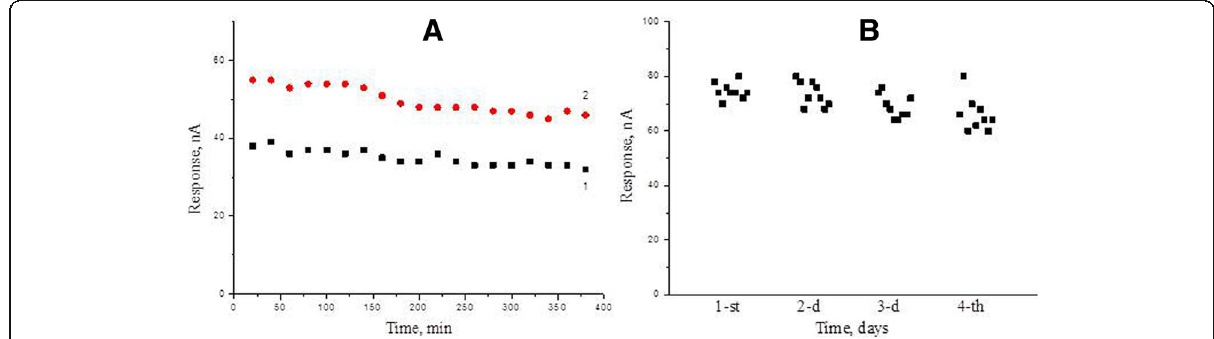
Fig. 9 Reproducibility of biosensor responses to 0.5 mM (1) and 1 mM (2) glutamate during one working day ( a ) and operational stability of the biosensor responses to 1 mM glutamate during four days ( b ). Measurements in 25 mM HEPES buffer, pH 7.4, at a constant potential of +0.6 V vs Ag/AgCl reference